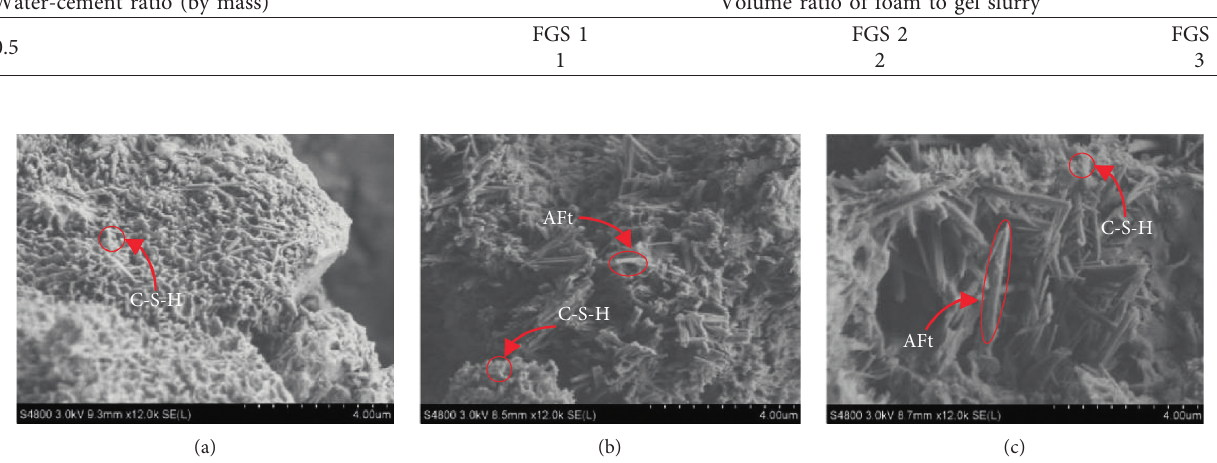
Figure 4: SEM image of OPC cured foam filling material when molded for one day. (a) FGS 1. (b) FGS 2. (c) FGS